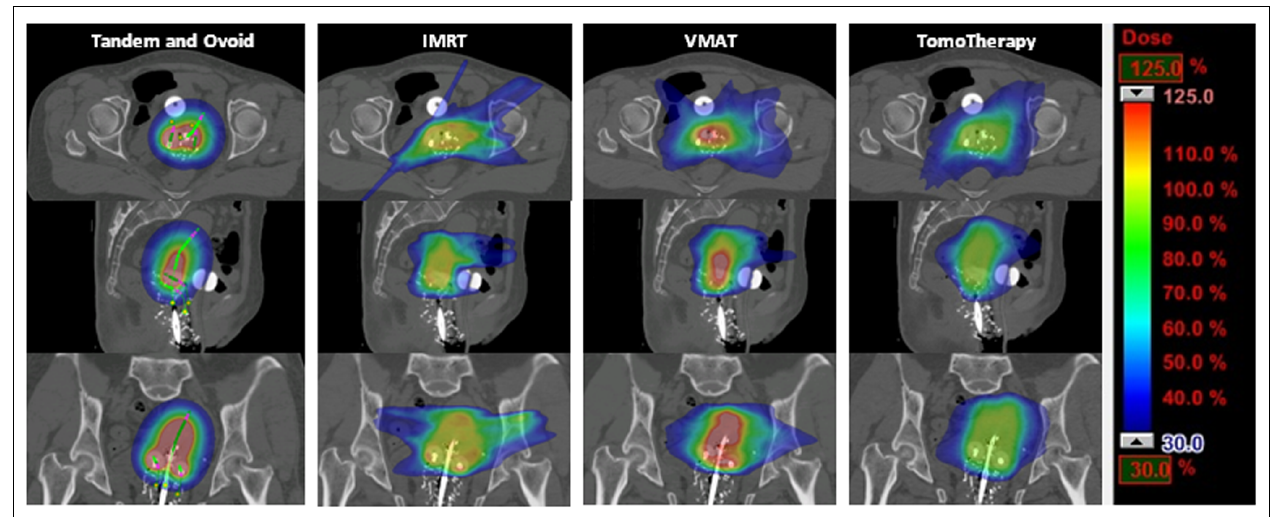
FIGURE 1 |Axial, sagittal, and coronal views of dose distribution among tandem and ovoid, intensity-modulated radiotherapy, volumetric modulated arc therapy, andTomoTherapy techniques for a representative patient.